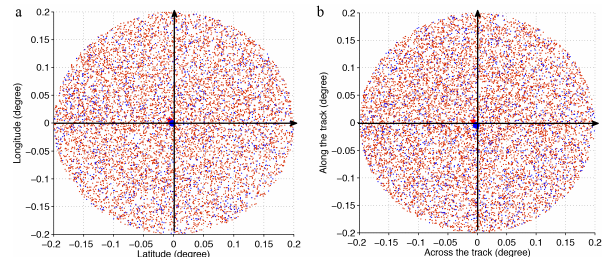
Figure D1. Schematic scatter plots showing Argo floats’ drift- ing destination from the origin. The two coordinate systems are (a) latitude–longitude, with the location of the float before storm as the origin, and (b) track direction as the y axis, and the location of the float before the storm as the origin. The red dots are the des- tination of the pairs with pairs from the same float in red (with the mean in red star) and pairs from different floats in blue (with the mean in big blue dot).